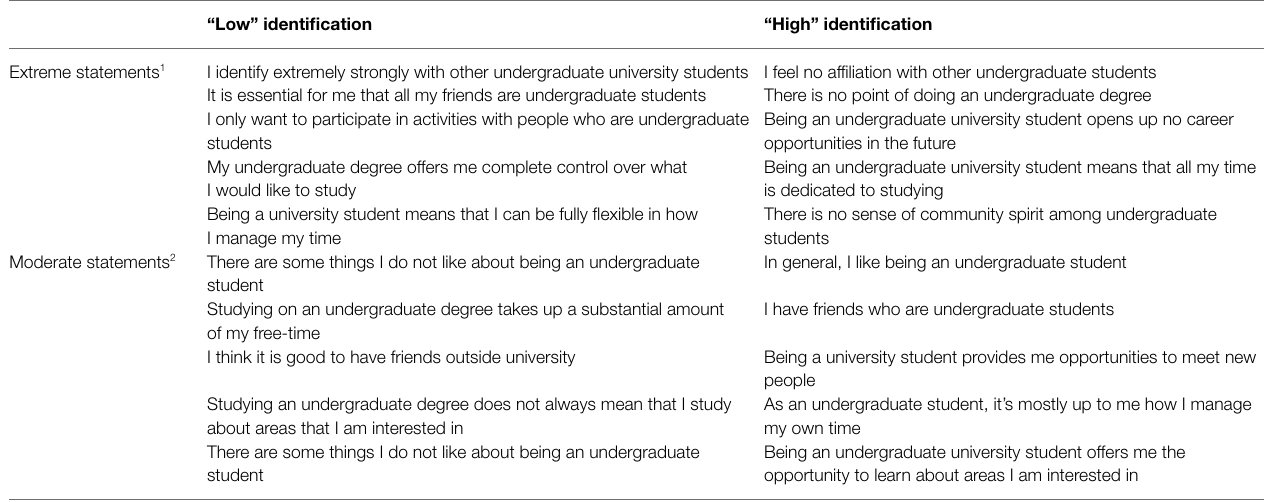
TABLE 1 | Identification manipulation items created following the example of Greenaway et al. (2015). “Low”